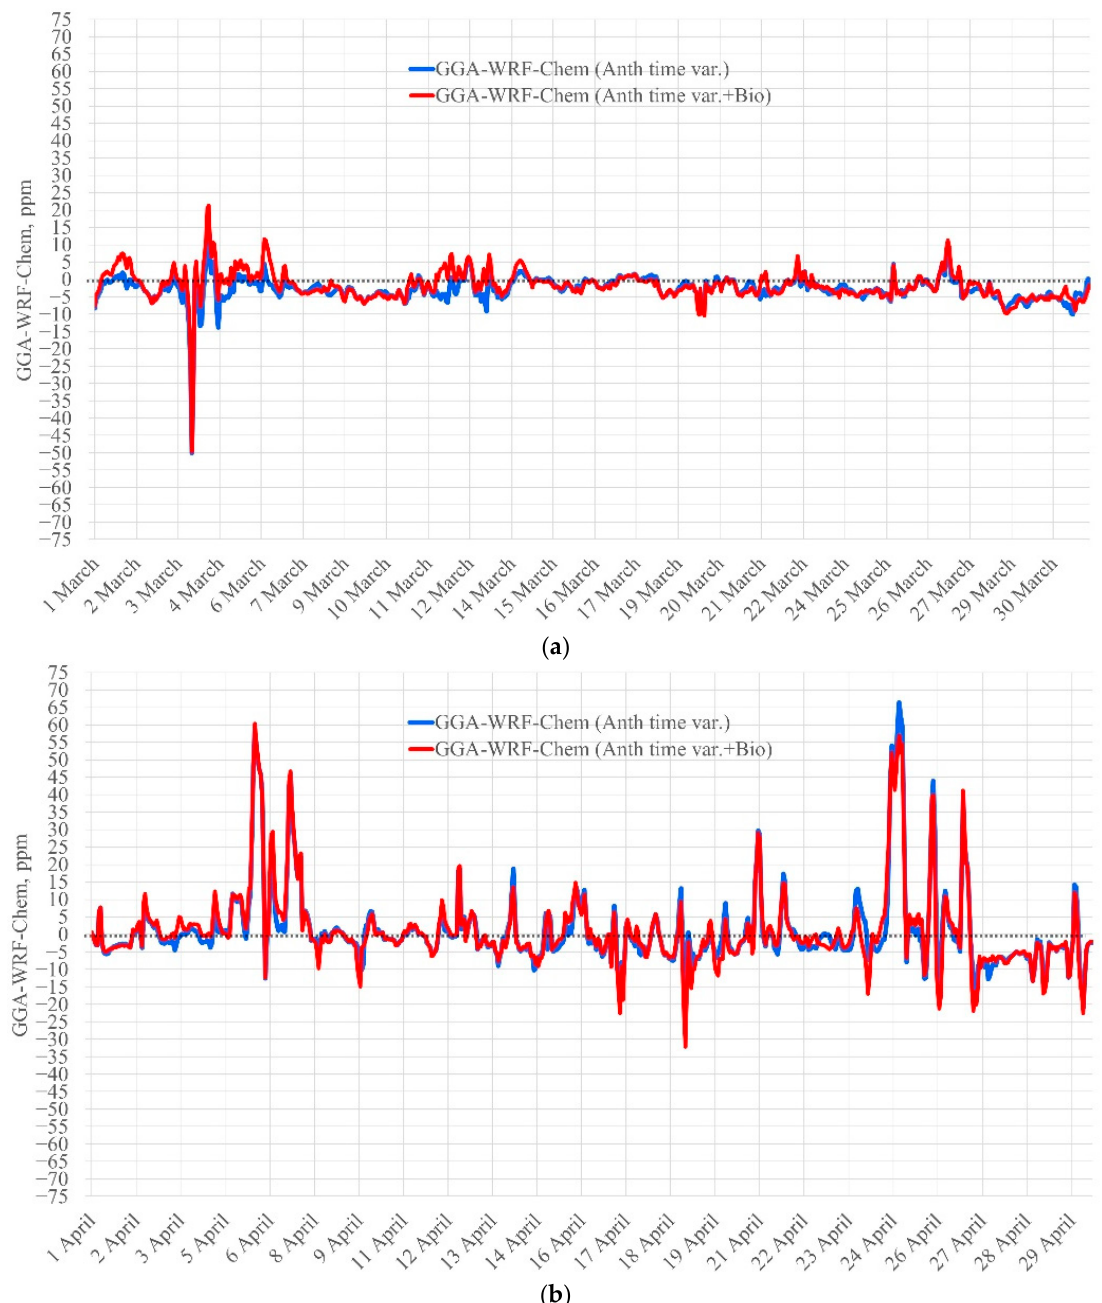
Figure 10. Temporal variation (1 h) in surface atmospheric CO 2 mixing ratio differences between the WRF-Chem runs with time-varying biogenic and anthropogenic fluxes and only with time-varying anthropogenic emissions and in situ observations in Peterhof in March ( a ) and April ( b ) 2019. Anth: anthropogenic emissions; Bio: biogenic fluxes; time var.: time-varying.